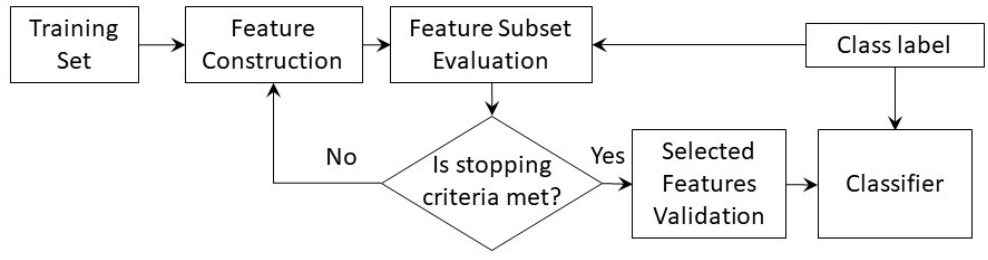
Figure 6. Filter techniques framework used for feature selection.